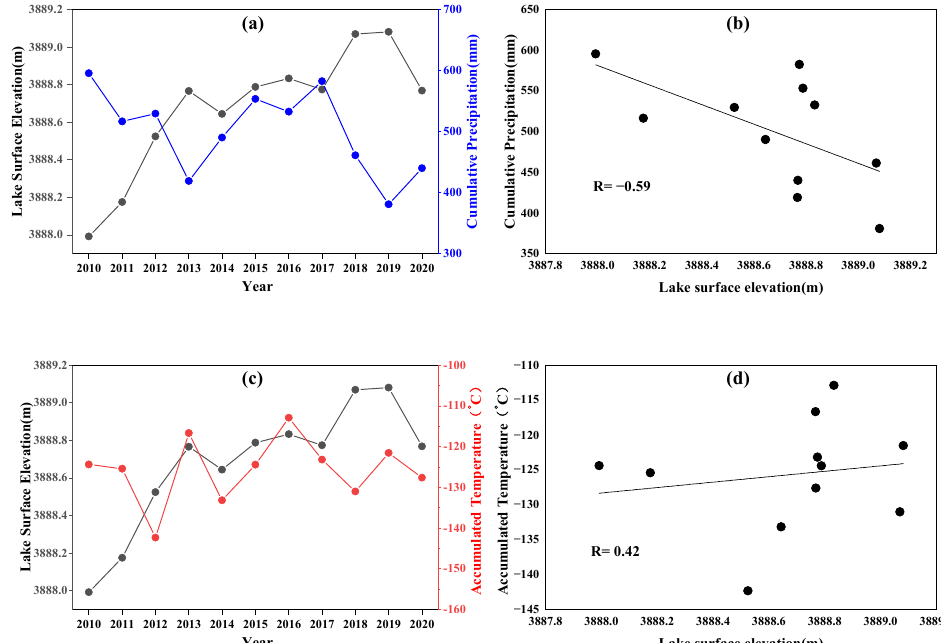
Figure 7. ( a ) Annual cumulative precipitation and lake surface elevation curves of Lake Karakul. ( b ) Correlation between cumulative precipitation and lake surface elevation. ( c ) Annual cumulative temperature and lake surface elevation curves of Lake Karakul. ( d ) Correlation between cumulative temperature and lake surface elevation.